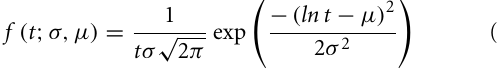
( Figure 2 ). For spinal interneurons (spInt, N = 9,